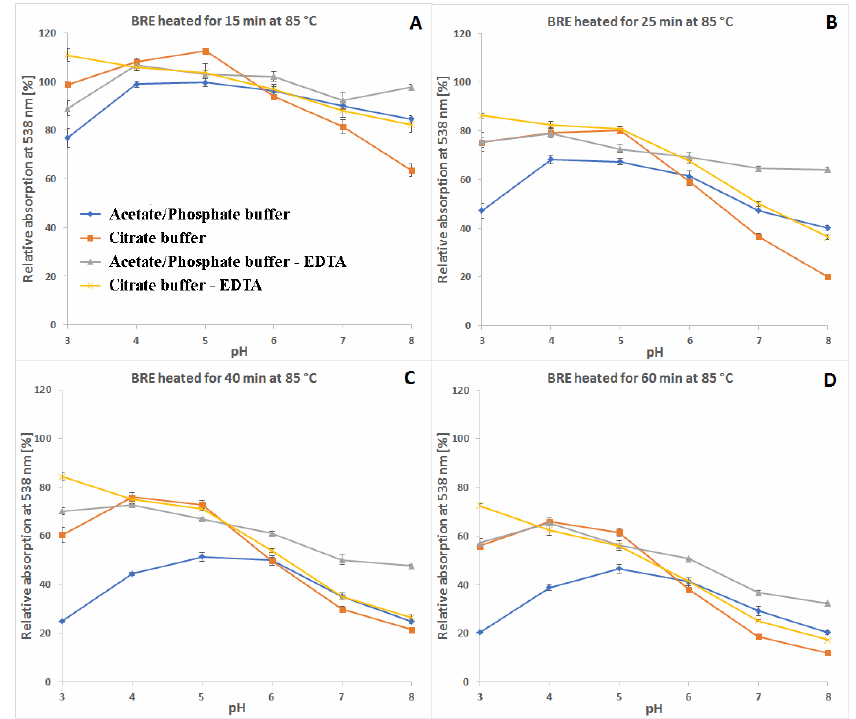
Figure 6. Relative absorption of red-violet pigments monitored at λ 538 nm after 15 ( A ), 25 ( B ), 40 ( C ) and 60 min ( D ) of heating (85 °C) of betalain-rich extract (related to its starting value before heating) in acetate/phosphate and citrate buffers with optional addition of EDTA.